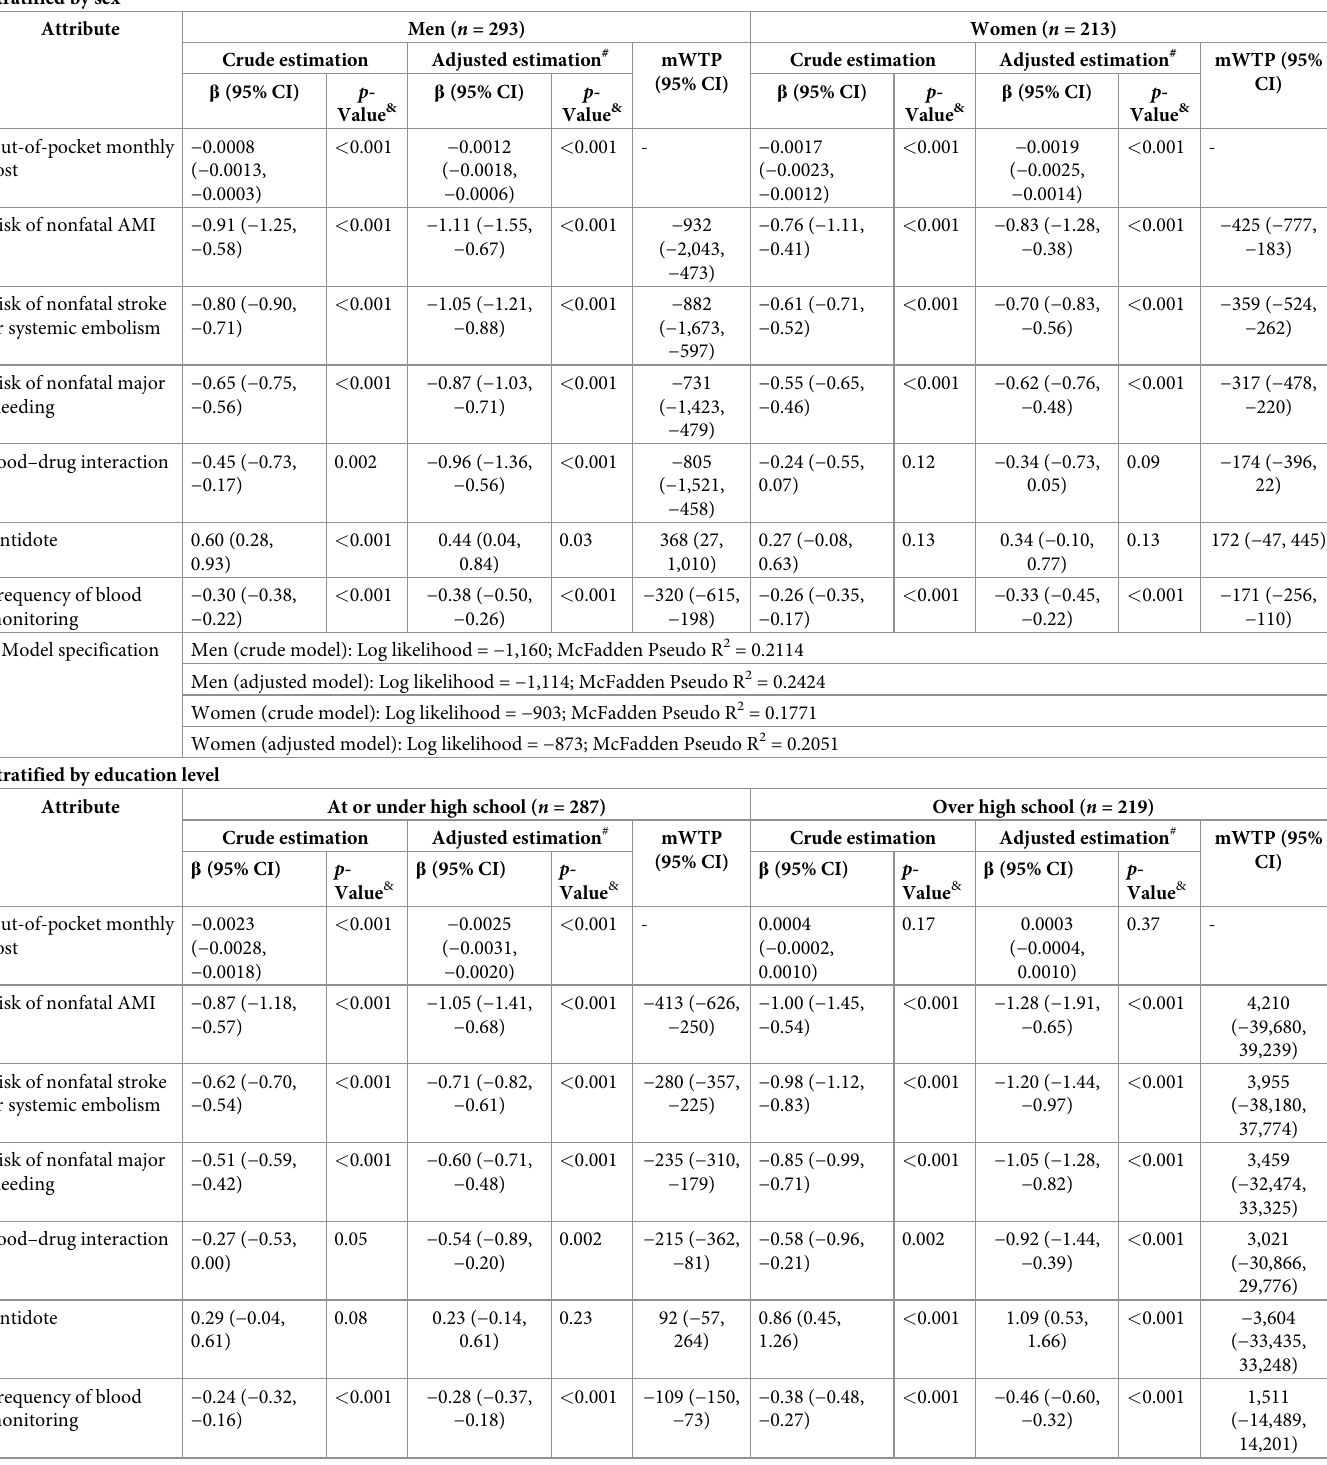
Table 4. Preference weights estimated by mixed logit regression model and mWTP (RMB � ) in subgroup